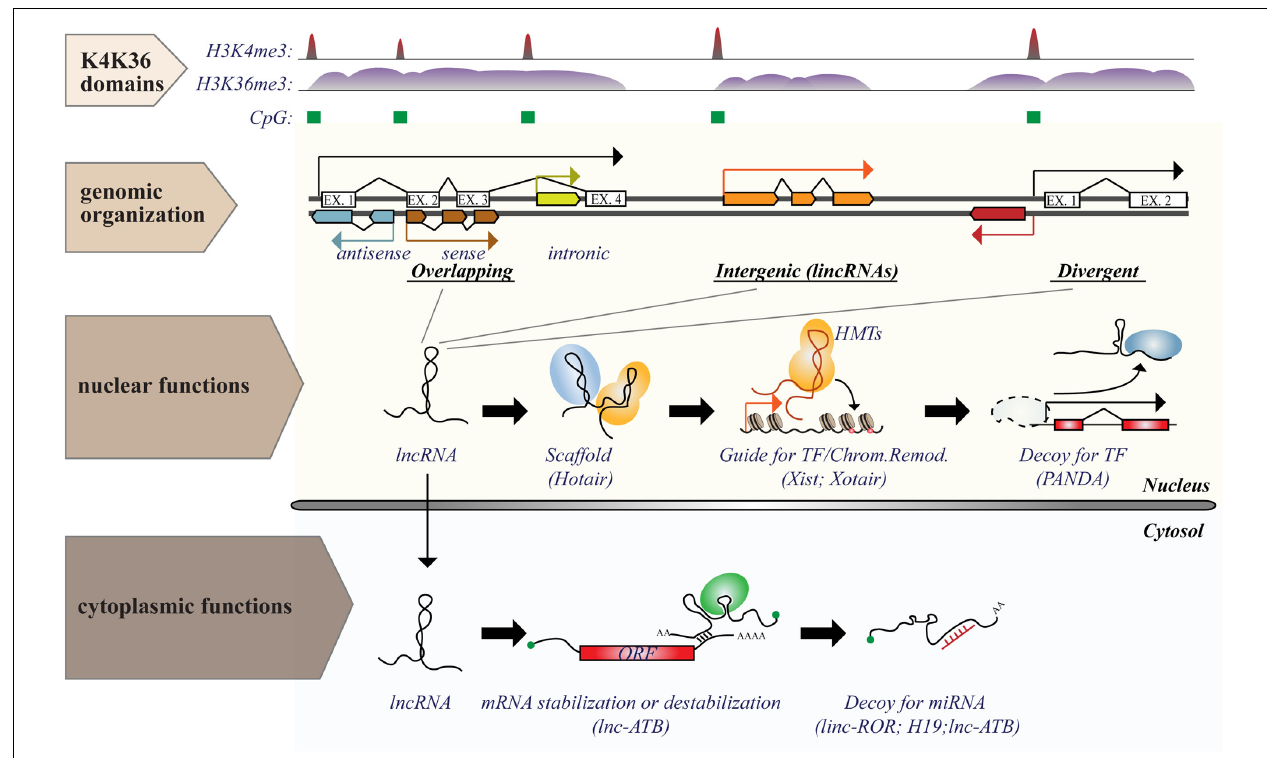
[such as CpG island (green boxes) or histone marks (histone H3 “K4K36 domains”)] provide a useful strategy to identify expressed lncRNAs. Functions of lncRNAs are executed by multiple modes of action and can occur both in the nucleus and in the cytosol. The figure shows some examples of nuclear or cytoplasmic functions of some known